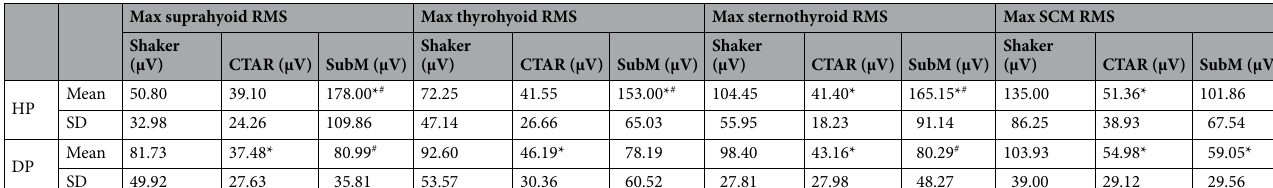
Table 2. The maximal RMS value of the suprahyoid, thyrohyoid, sternohyoid, and SCM muscles in healthy participants and patients with dysphagia. RMS, root mean square; SD, standard deviation; CTAR, chin tuck against resistance; SubM, submandibular push exercise; SCM, sternocleidomastoid; Max, maximum; HP, healthy participants; DP, dysphagic patients. vs. Shaker, * p < 0.05; vs. CTAR, # p < 0.05.